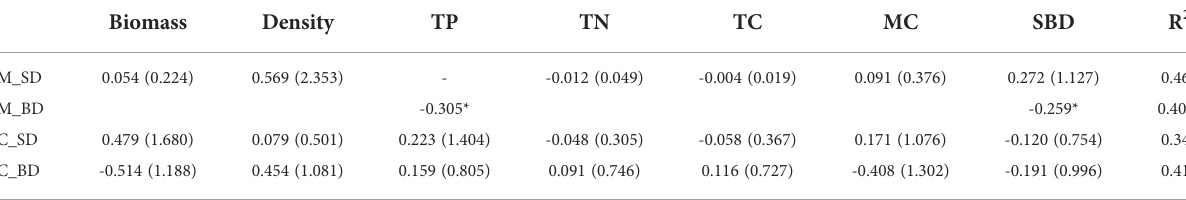
TABLE 4 Regression models between seed/bud density and environmental